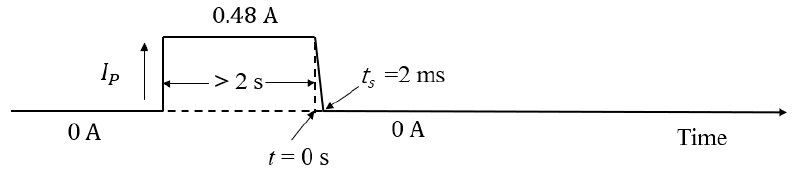
Figure 7. The current through the B p coil during the test.